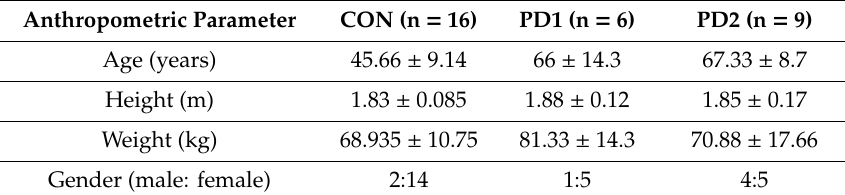
Table 1. Anthropometric details of all